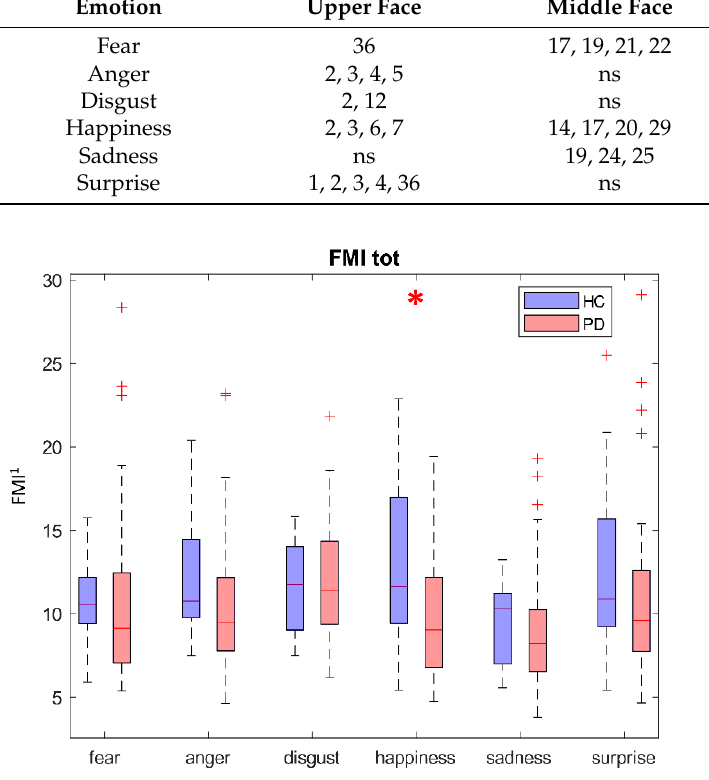
Figure 5. Boxplot of the total FMI per emotion. The x-axis represents the different emotions; the y-axis reports the value of FMI . HC and PD subjects are described in blue and red, respectively. Greater values of FMI represent greater deviation from the neutral expression. Red * highlights statistically significant differences at the 0.05 confidence level. FMI 1 is dimensionless.